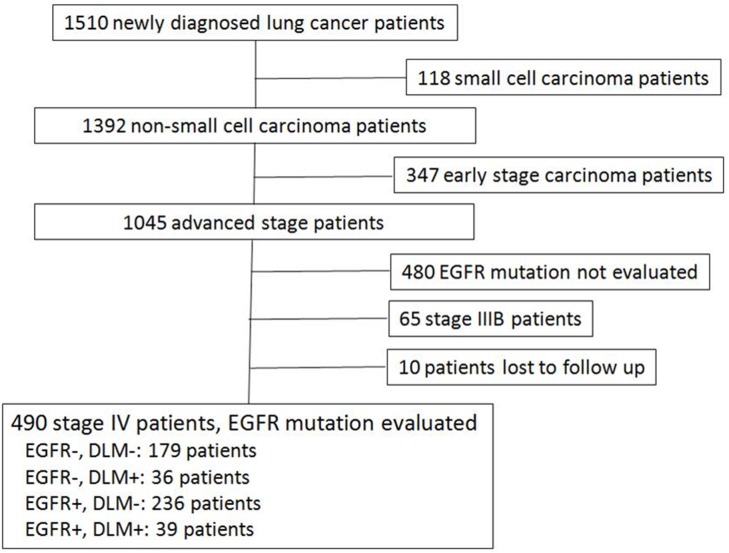
Inclusion and patient selection.